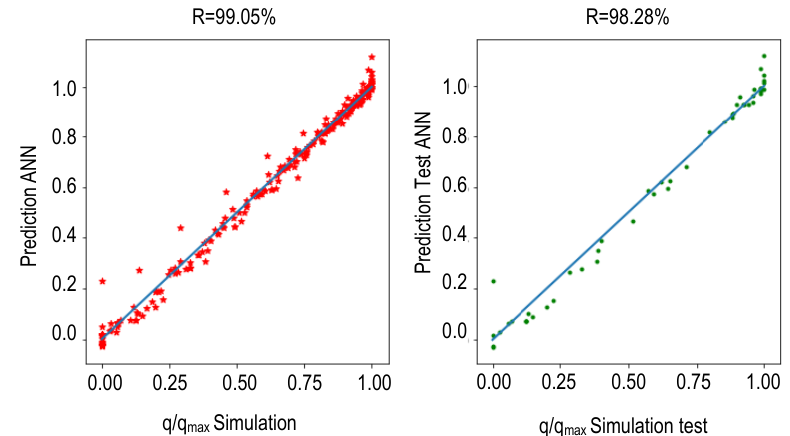
Figure 8. The correlation of R-Score of the ANN model.